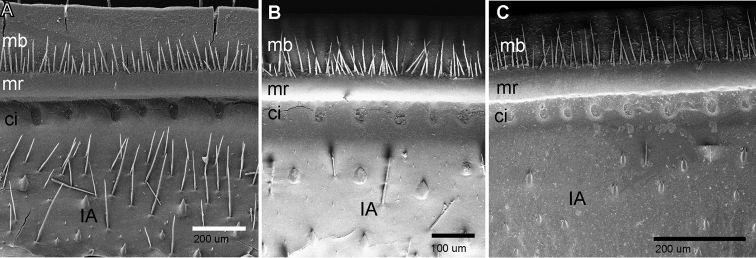
SEM, Endotergum of mid body tergites, ventral view. AZoosphaerium
mangabe sp. nov., male from Marojejy BZoosphaerium
bartolozzii sp. nov., male holotype CZoosphaerium
taitii sp. nov., male holotype. Abbreviations: IA = inner area; ci = cuticular impressions; mr = marginal ridge; mb = marginal bristles.